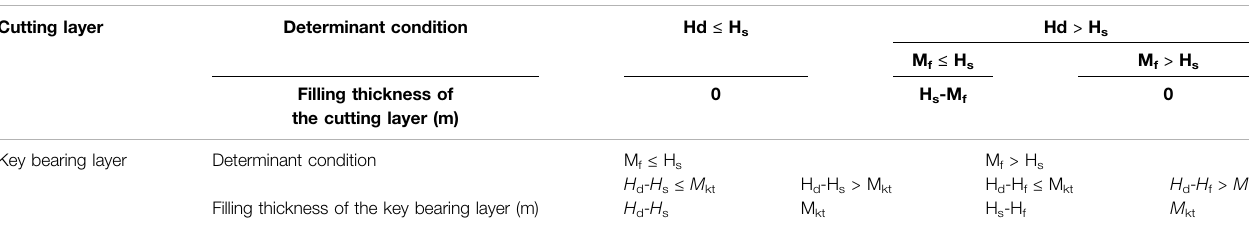
TABLE 1 | Determination method of thickness of the cutting layer and key bearing